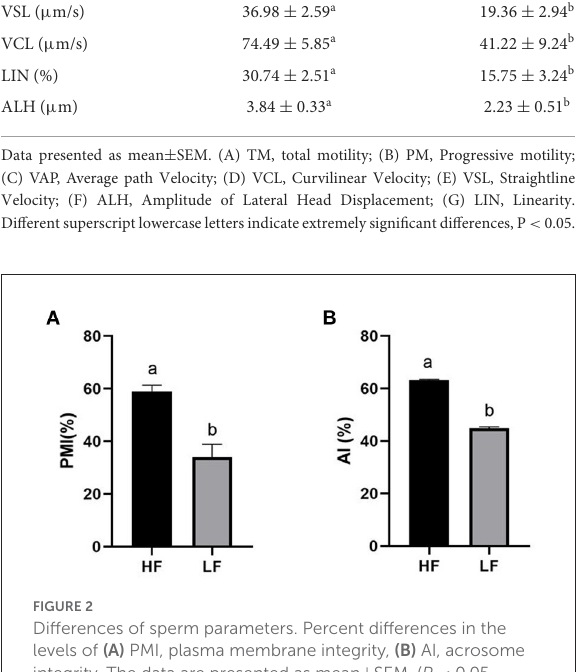
significant differences between HF and LF ( P < 0.01, Table